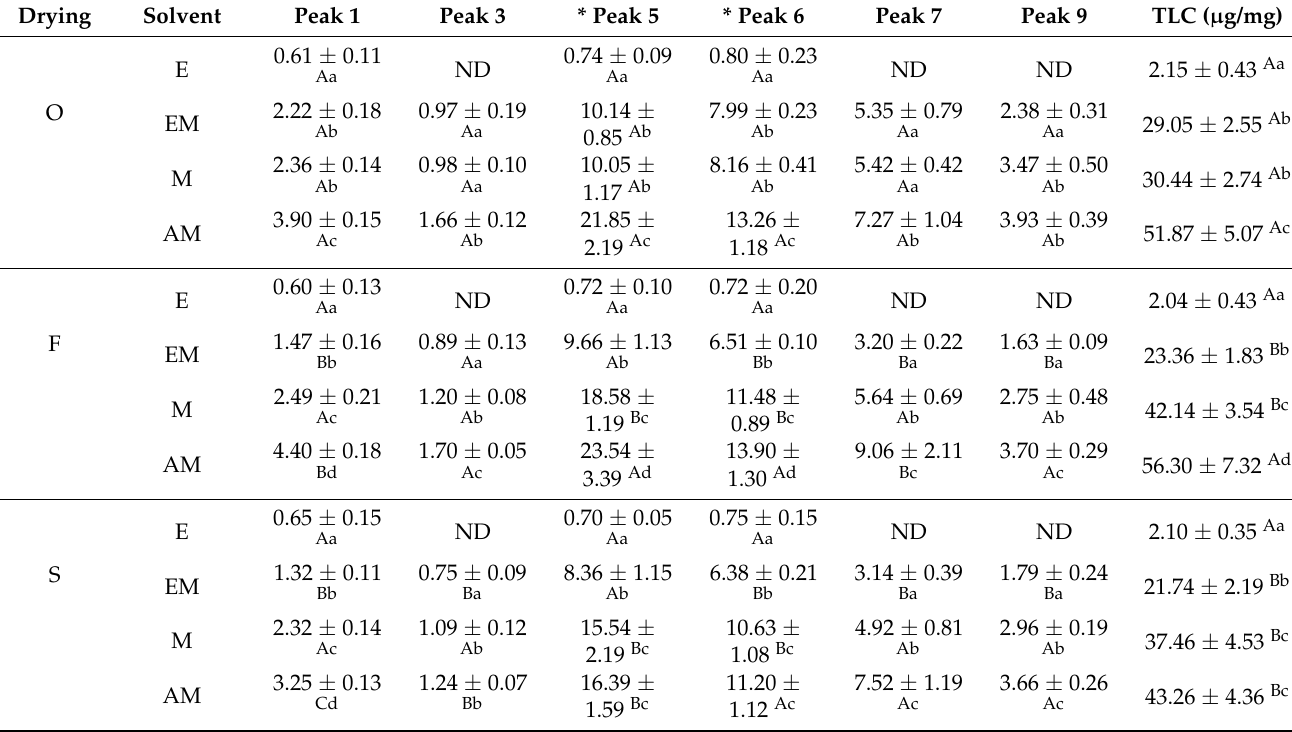
Table 3. Relative quantification of luteolin derivatives in OPL extracts obtained from various drying methods and solvent